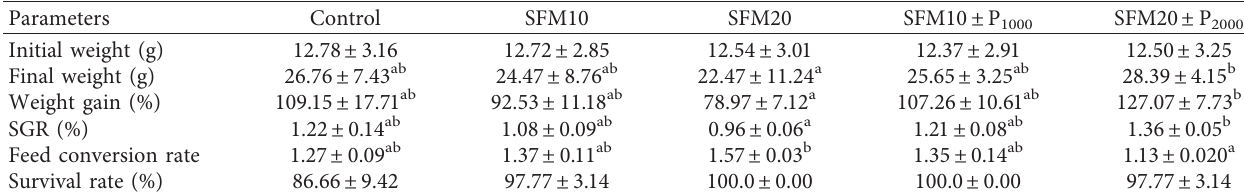
Table 3: Growth performance and feed conversion rate analyses in the experiment